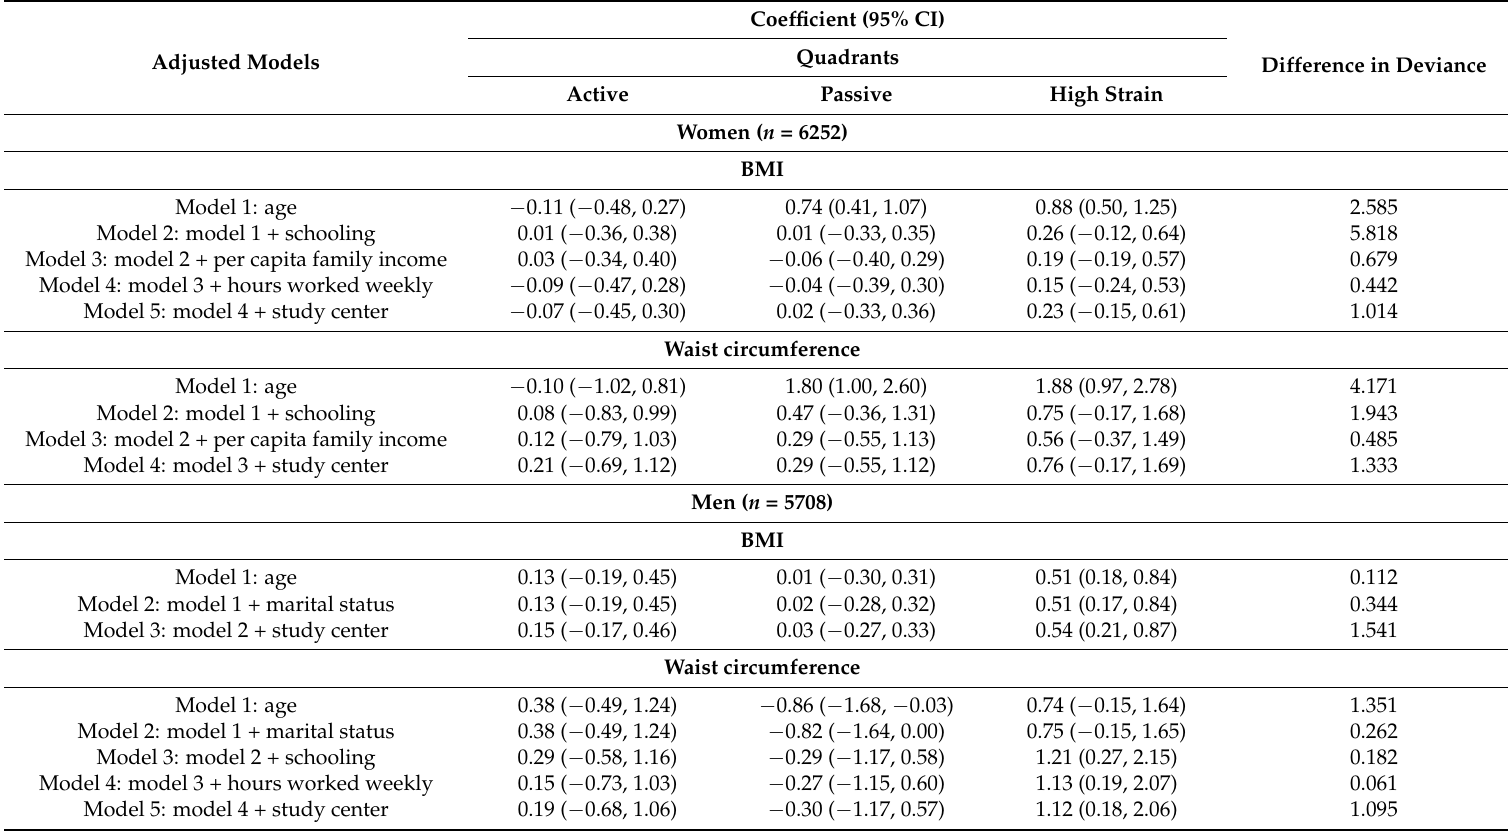
Table 2. Coefficients and respective 95% confidence interval (CI) of the association between job strain and adiposity (BMI and WC) in adjusted gamma regression models by gender. ELSA-Brasil, 2008–2010 ( n =